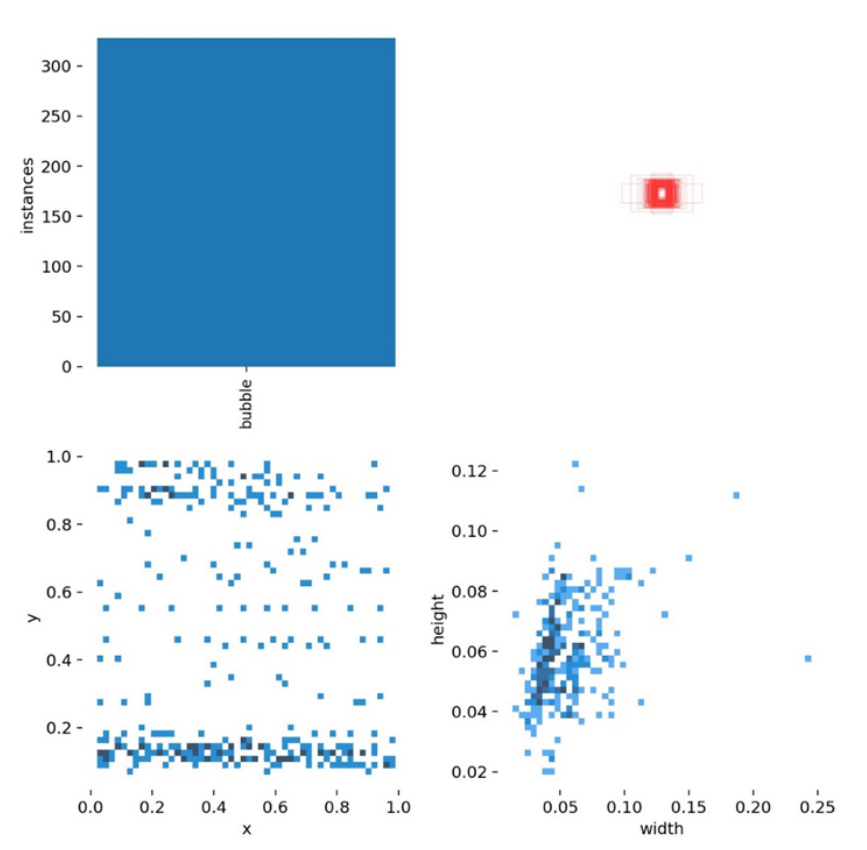
Figure 5. Bounding box coordinates and size distribution plot. Statistical image of the number of bubble defects ( upper left ); All bounding box size images ( top right ); Bounding box relative position distribution image, x and y are the coordinates of the relative position of the bubble in the image. ( bottom left ); the height and width of the bubble ( bottom right